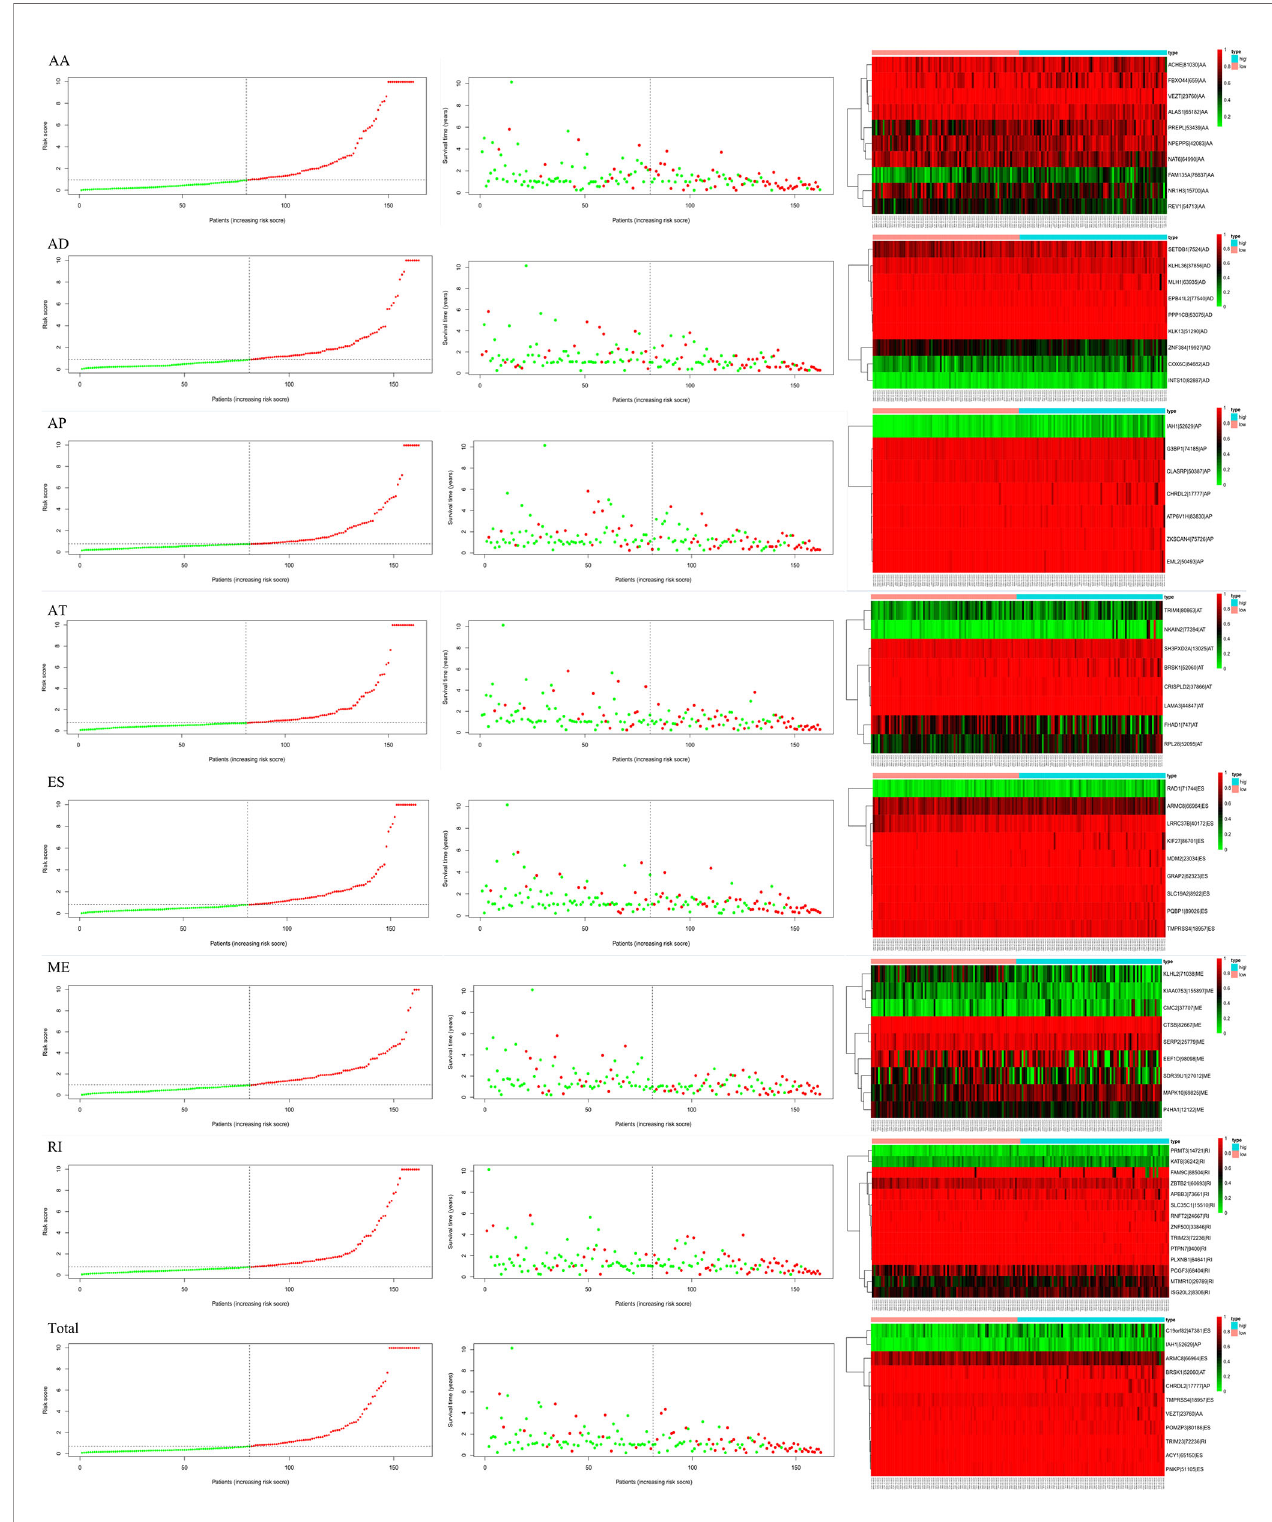
FIGURE 6 | Survival time, risk score distribution, and expression heatmap of AS events associated with